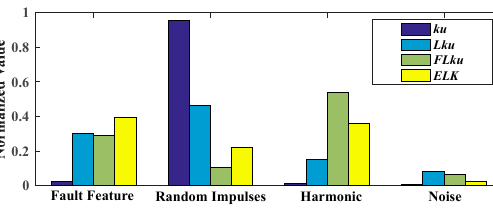
Figure 1. Components of the simulated signal: ( a ) fault feature signal; ( b ) random impulses; ( c ) harmonic components; ( d ) white noise.